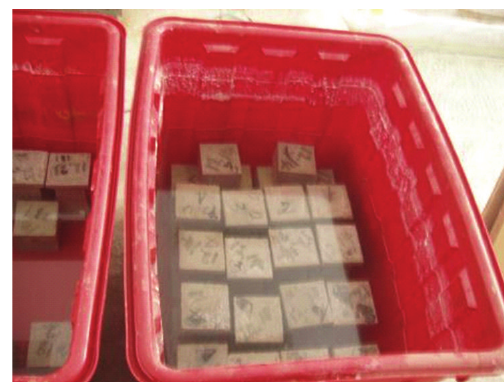
Figure 2: Concrete specimens exposed to the similated acid rain.